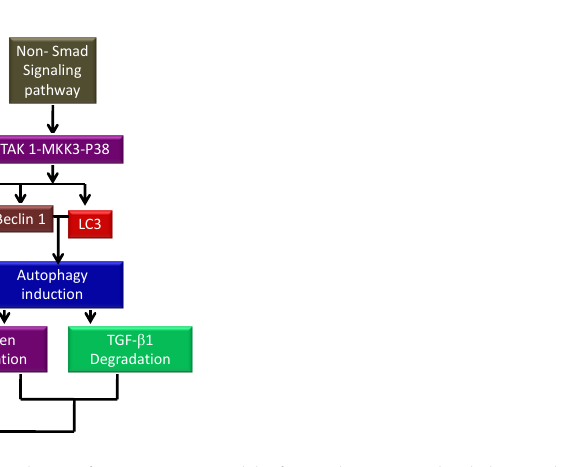
Figure 4. Schematic showing the autophagic factors responsible for inducing and inhibiting kidney fibrosis. p-Smad signaling increases collagen I production deposition leading to the development of renal fibrosis. On the other hand, non-Smad signaling inhibits fibrosis by inhibiting autophagy-mediated degradation of TGF- β 1.